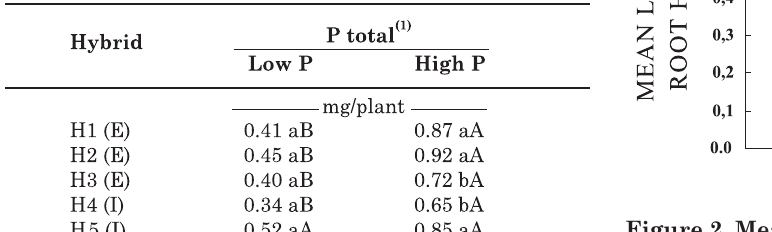
Figure 2. Mean length of root hair of seminal, nodal and lateral roots of maize hybrids contrasting in P-use efficiency. Means followed by the same letter did not differ significantly by the Scott- Knott test, at